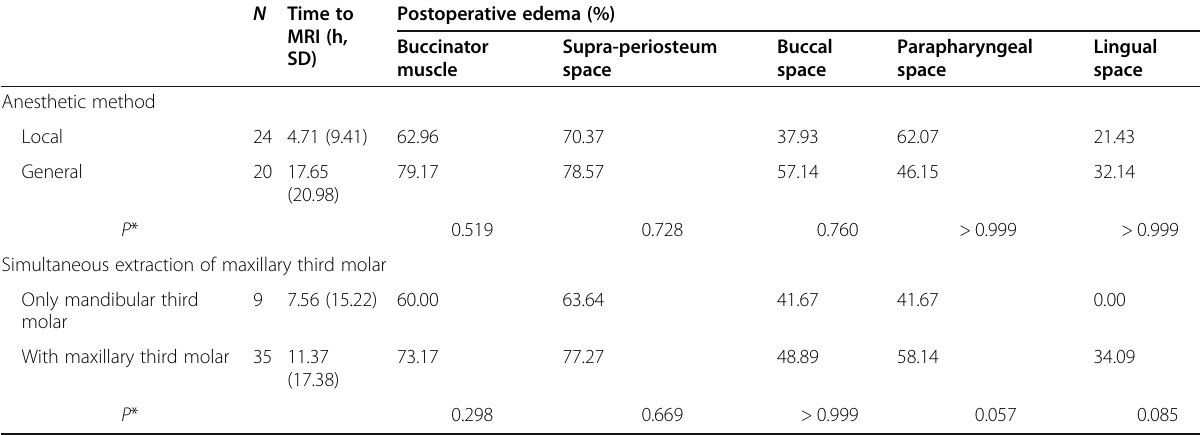
Table 2 Incidence of postoperative edema for each space according to the anesthetic methods and maxillary third molar extraction N Time to MRI (h,